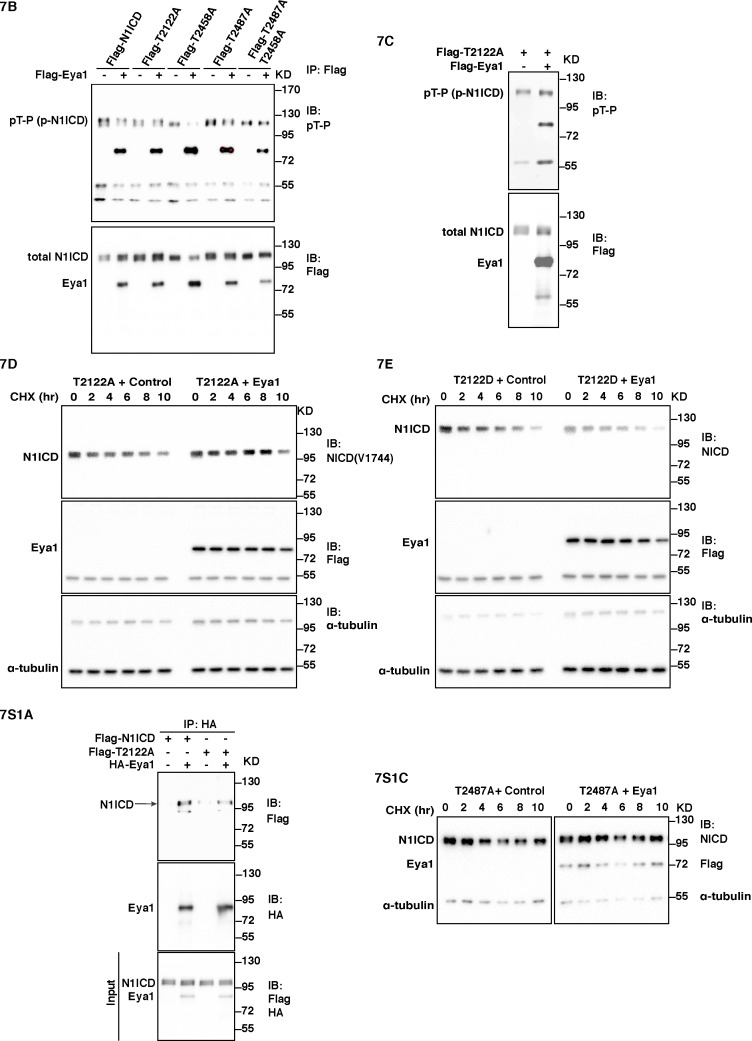
Complete western blots for Figure 7 and Figure 7—figure supplement 1.